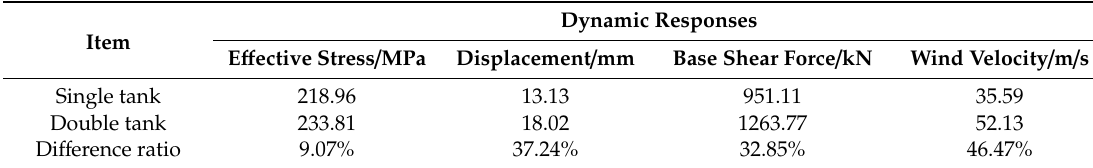
Table 4. E ff ect of wind interference on absolute maximum